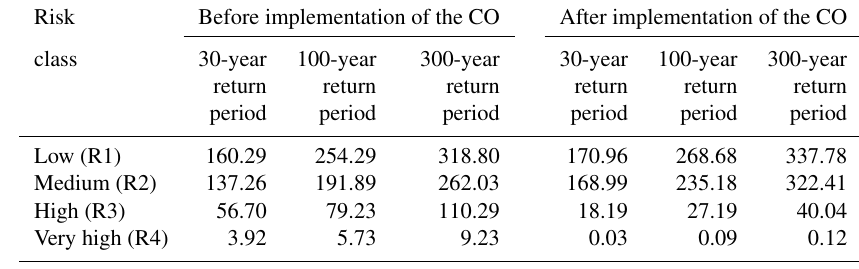
Table 8. The risk classes for each return period in terms of area flooded (km 2 ) before and after implementation of the CO.